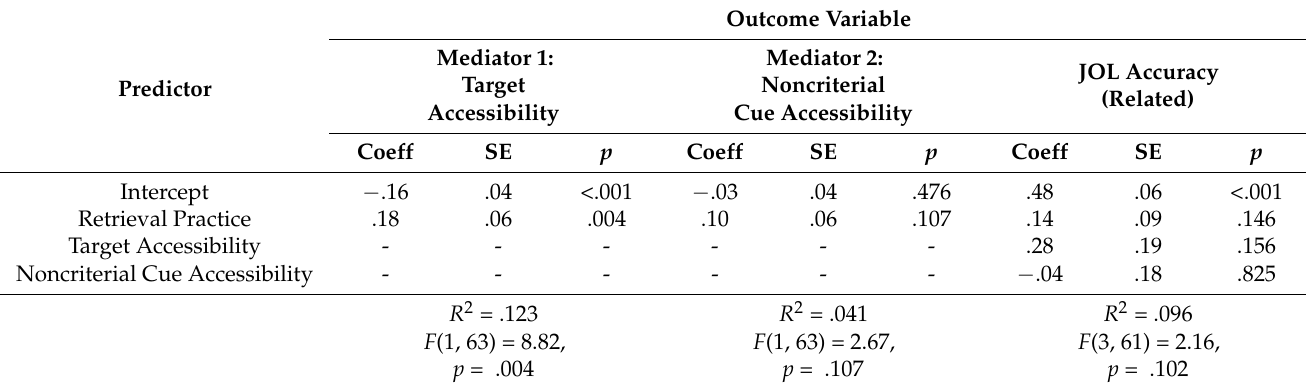
Table 9. Experiment 2—Mediation Model